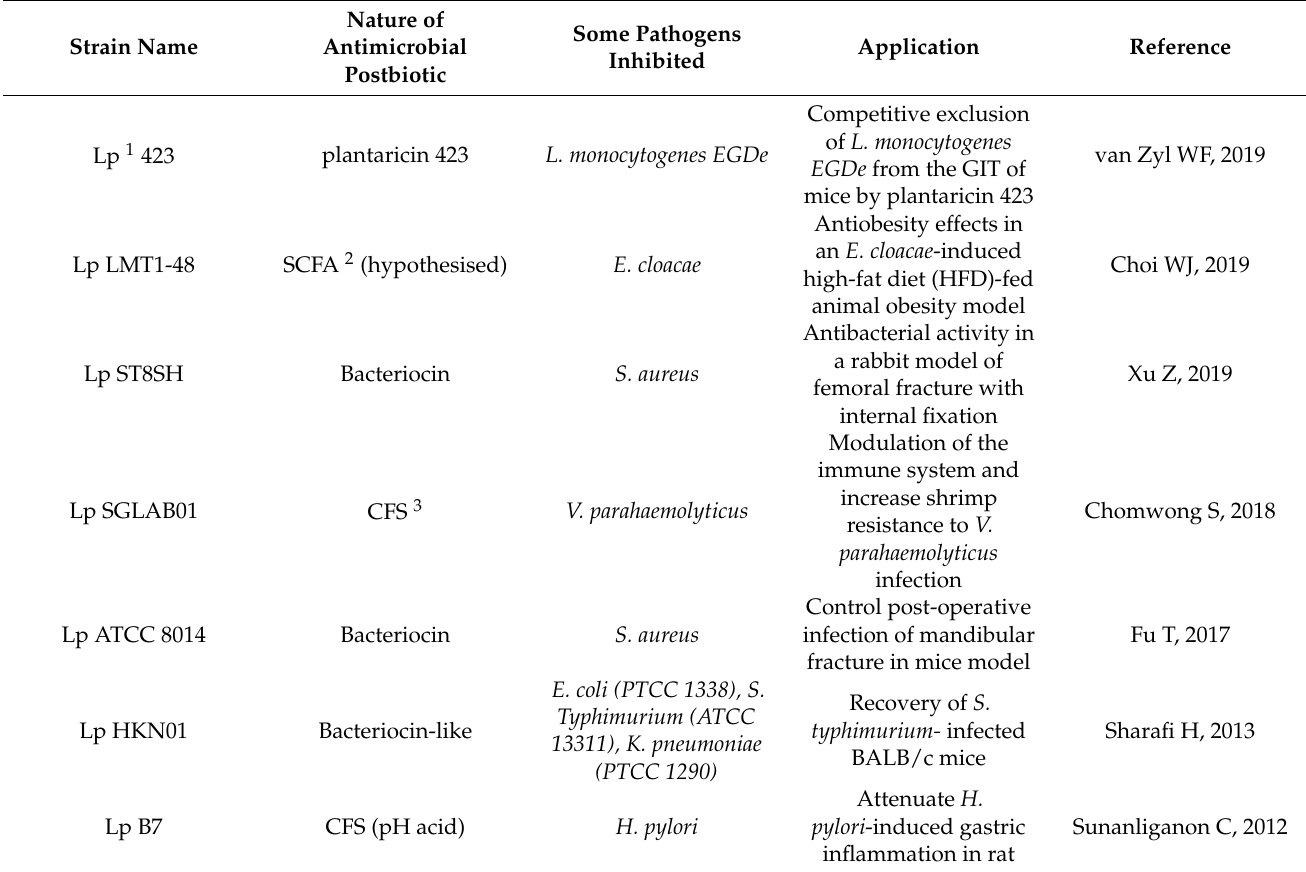
Table 3. L. plantarum strains with antimicrobial activity, whose probiotic and antipathogenic efficacy was tested in vivo (clinical and/or preclinical